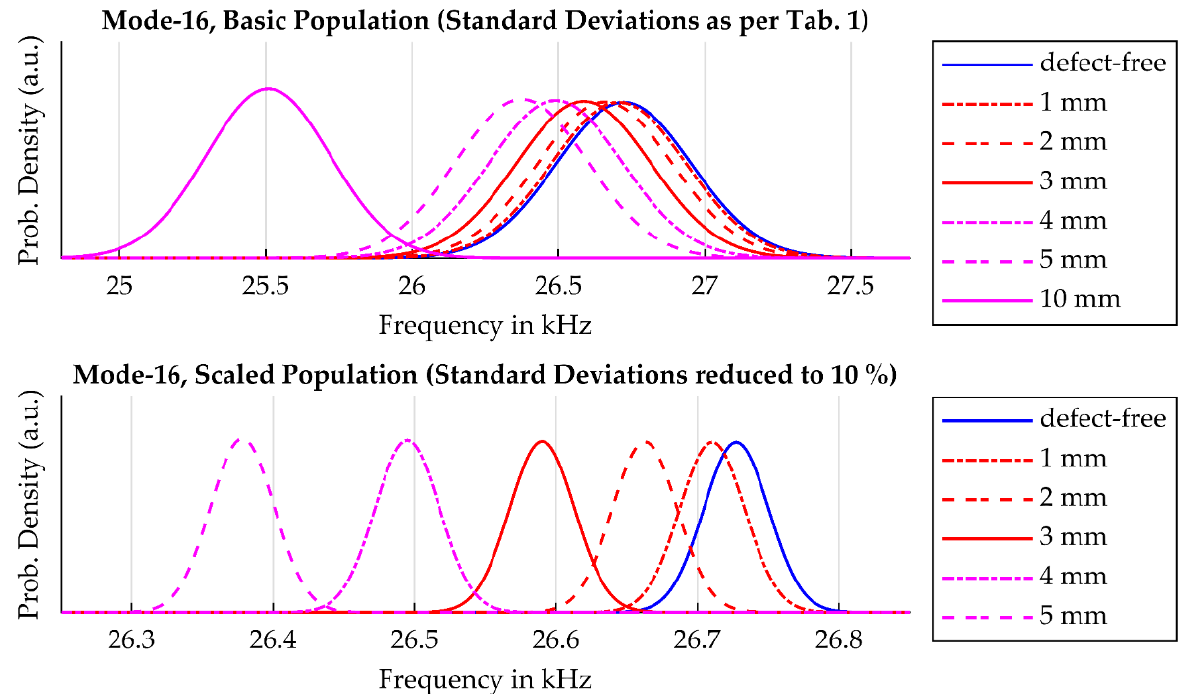
Figure 7. Eigenfrequency distribution for connecting rods depending on quality state and amount of geometric part-to-part variations regarding Mode-16.